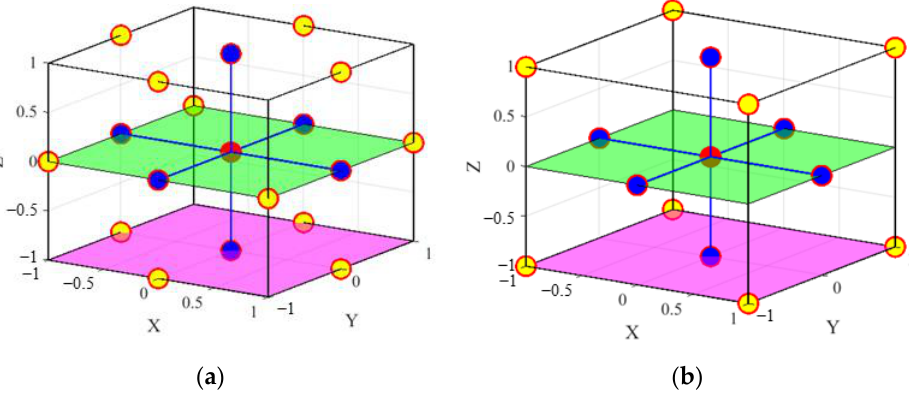
Figure 8. Illustration of sample points for N = 3: ( a ) Bivariate Cut-HDMR with s = 3 and ( b ) CCD, where the red point is the mean point.